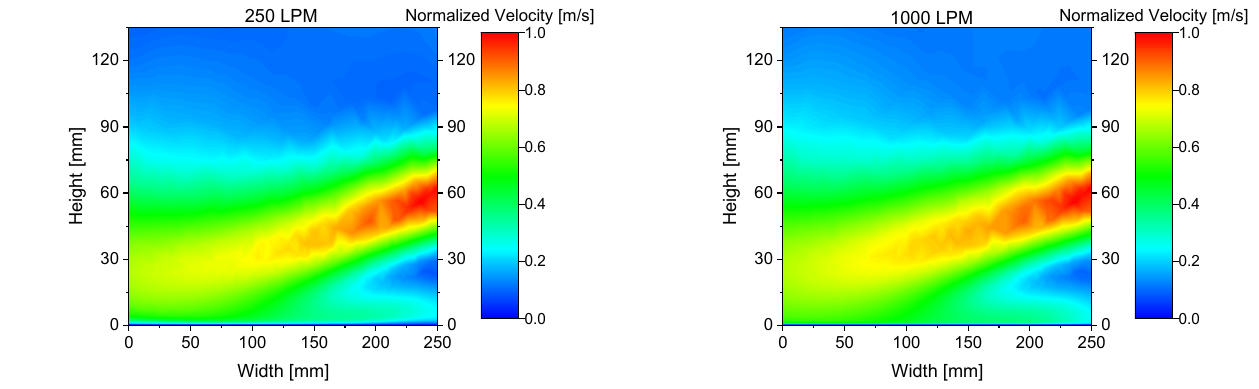
Figure 7. Velocity profiles normalized by maximum velocity in the central vertical plane for different gas flow rates. ( Left ): 250 LPM and maximum velocity of 1.5 m/s. ( Right ): 1000 LPM and maximum velocity of 6 m/s.